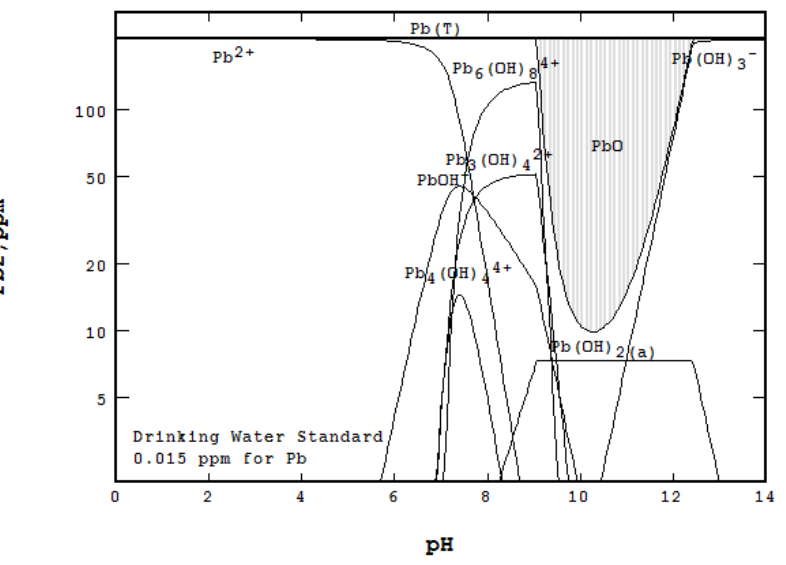
Figure 5. Solubility of PbO (shaded) versus pH. PbO does not provide good corrosion protection, even at elevated pHs.